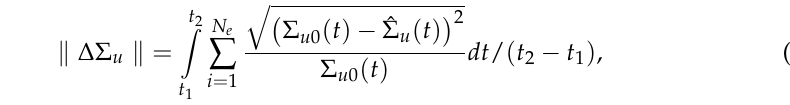
(cid:107) and (cid:107) ∆ ϕ norm (cid:107) for m dst